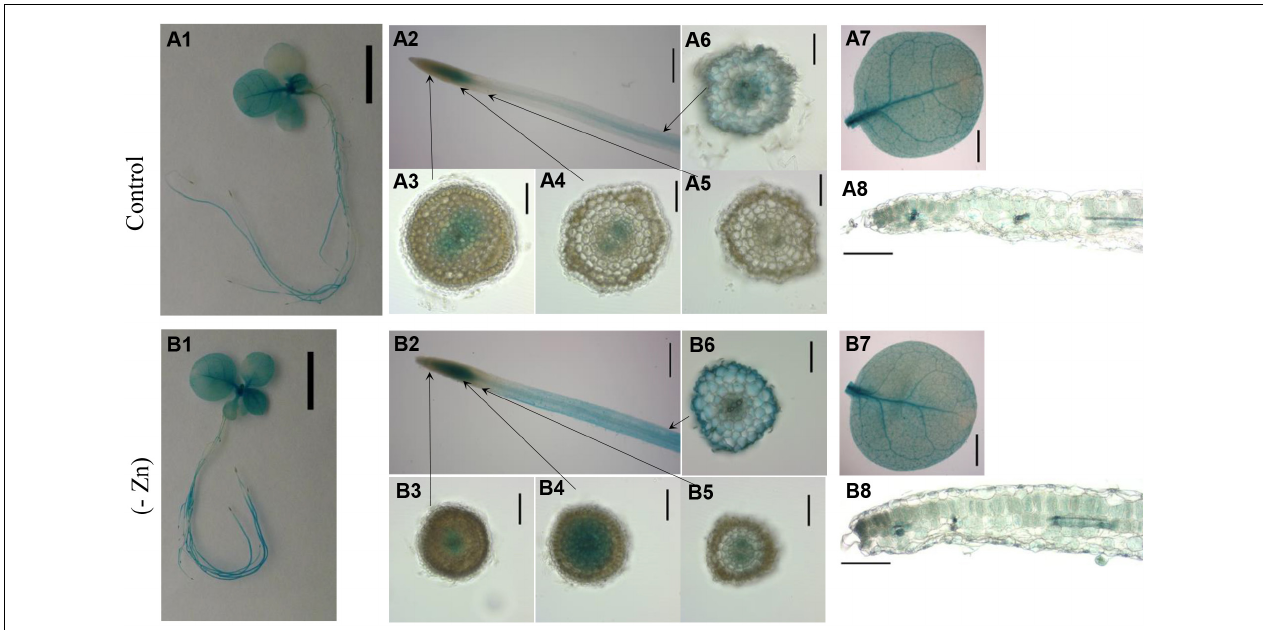
FIGURE 8 | GUS staining pattern of transgenic plants expressing NtZIPB p:: GUS fusion gene. GUS expression in 4-week-old transgenic and wild-type seedlings grown at control conditions (A1–A8) and in the Zn-deficient (-Zn) medium (B1–B8) for 4 days. Whole seedlings (A1,B1) ; apical root segments (A2,B2) ; cross sections through the roots (A3–A6,B3–B6) ; whole leaves (A7,B7) and the cross sections through leaves (A8,B8) . Magnification bars: 1 cm – A1,B1 ; 0.5 cm – A2,B2 ; 0.1 cm – A3–A6,B3–B6 ; 0.2 cm – A7,B7 ; 0.2 mm – A8,B8 .